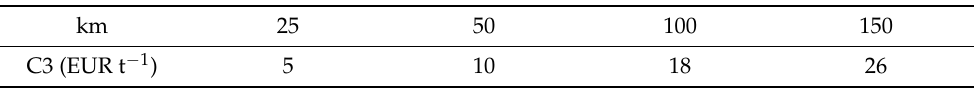
Table 8. Transport to final destination cost, according to the one-way distance for a truck with a load of 20.4